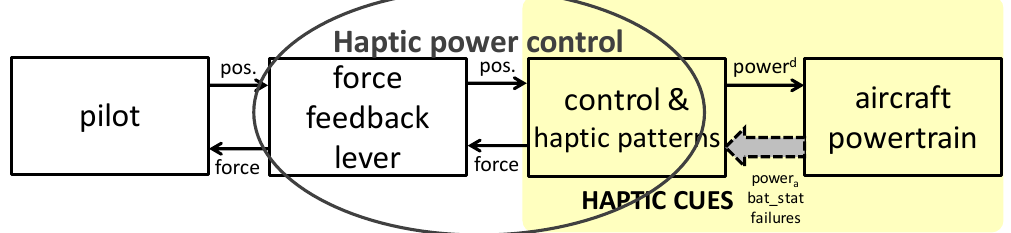
Figure 4. The concept of the powertrain control and haptic information flow with pilot-in-the-loop.